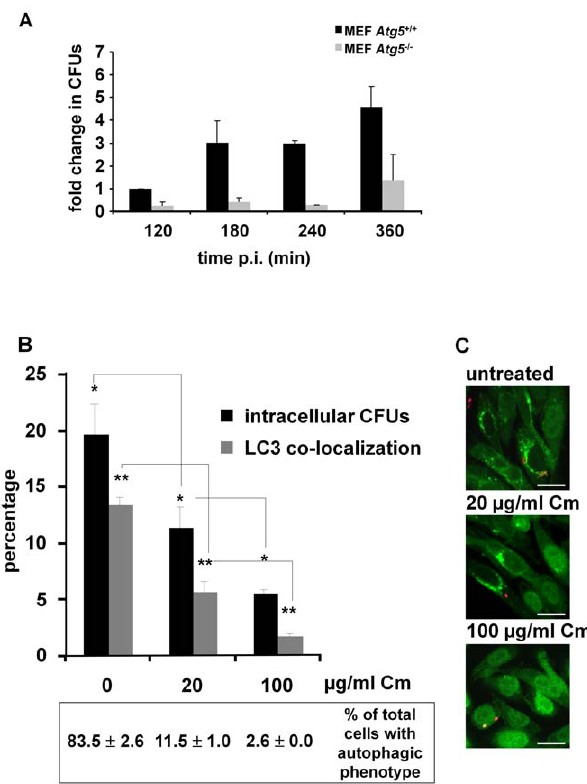
Figure 9. The autophagic process triggered by Serratia . A) Autophagy triggered by Serratia requires Atg5 . MEF Atg5 + / + and MEF Atg5 2 / 2 cells were infected for 60 min with wild-type S. marcescenes . Thereafter, extracellular bacteria were eliminated